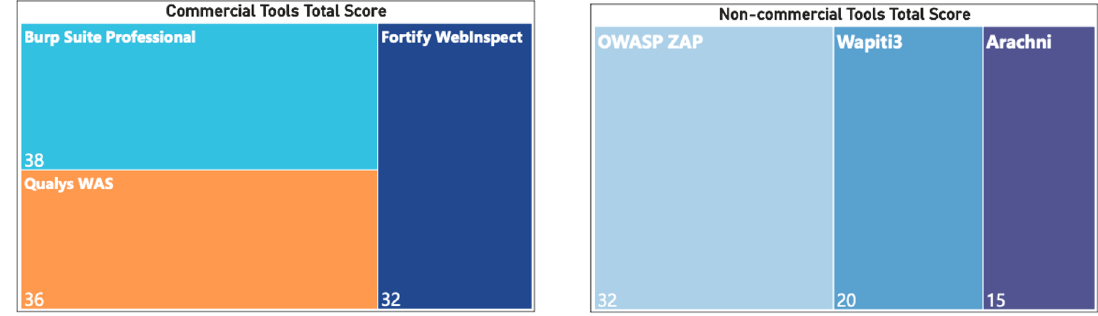
Figure 4. Top commercial and non-commercial pen-testing tools scores.